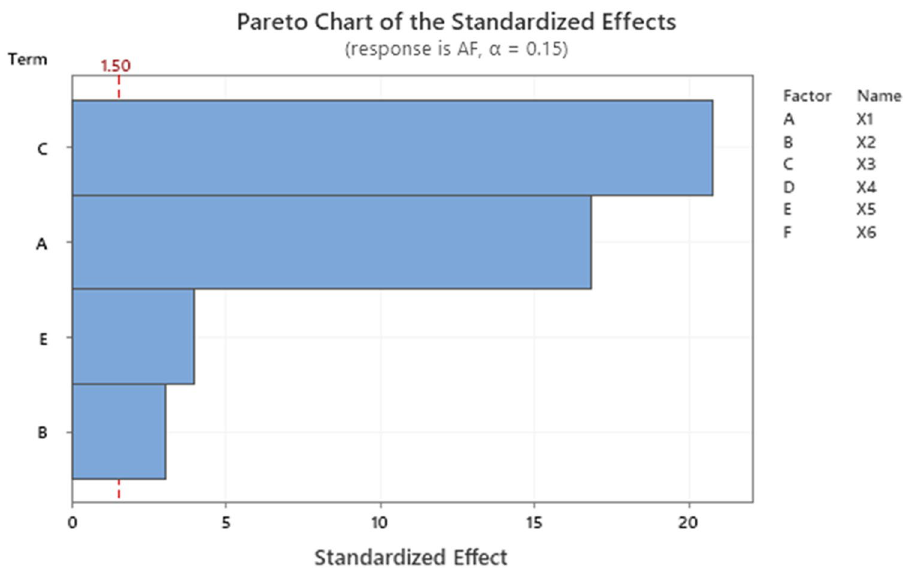
Fig. 10 Pareto chart of stand- ardized effects for BFQMLR of AF (only for terms which P value < 0.05. Here 1.55